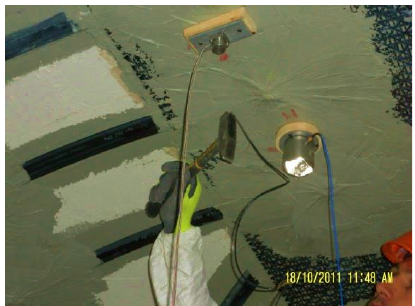
Figure 13. Sledge hammer applied to the crown of the vault intrados.